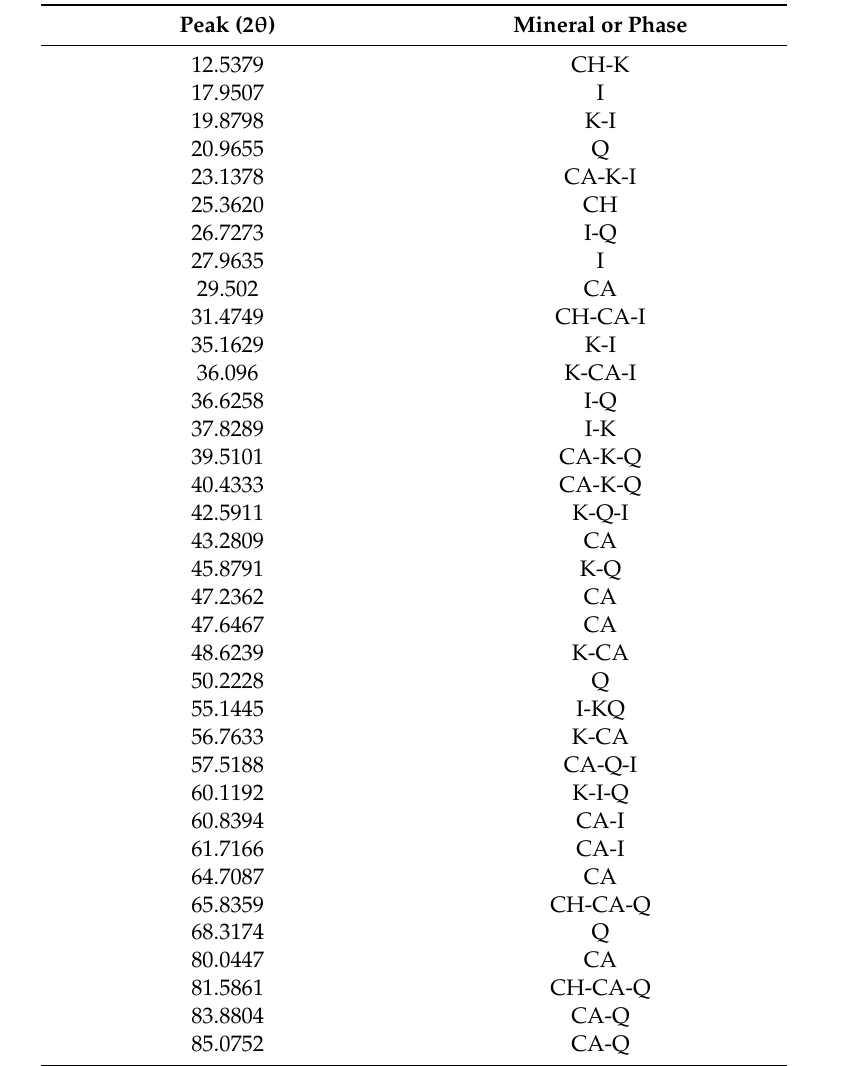
Figure 2. XRD pattern of TQ0. Table 3. XRD results of